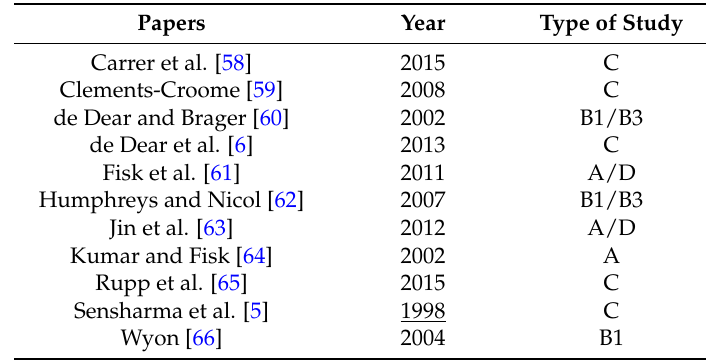
Table 3. Papers of the core set excluded from the co-citation analysis. The publication year is underlined if prior than 2000. Regarding the type of study: “A” indicates conceptual and theoretical studies, “B1”, “B2”, and “B3” are experimental studies performed, respectively, in the field, in the laboratory or through surveys, “C” is a literature review, and “D” are simulation